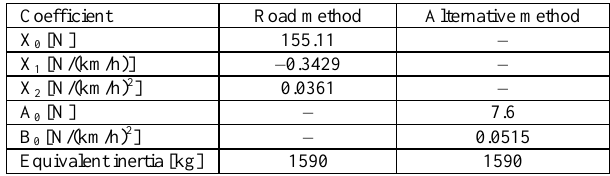
Table 3. Coefficients of resistance